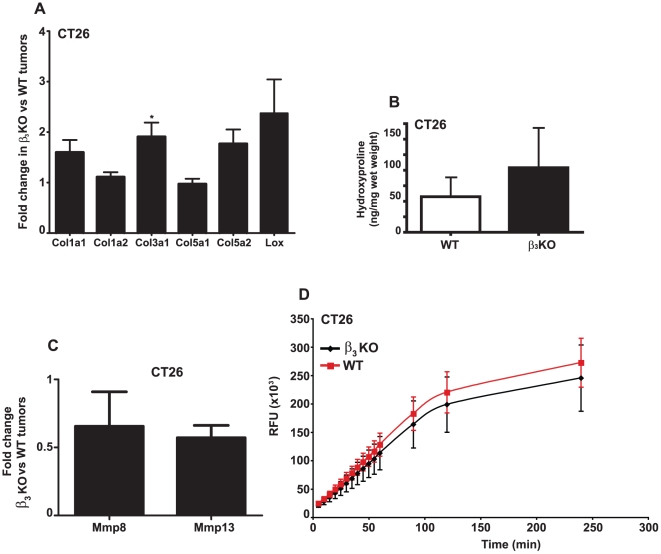
Quantitative RT-PCR analysis, hydroxyproline measurements and assay for MMP-13 activity.
A) Relative mRNA expression of fibrillar pro-collagens and lysyl oxidase (Lox) in CT26 carcinomas from integrin β3-deficient (n = 12) compared to WT mice (n = 11). Bars indicate fold changes in tumors from β3-deficient mice after normalization to tumors from WT mice using the 2−ΔΔCt method. * indicates p<0.05 with Student's t-test. Error bars are SEM. B) Hydroxyproline content in CT26 carcinomas grown in integrin β3-deficient and WT mice (n = 4 per genotype). Data was analyzed with Student's t-test. Error bars are SEM. Differences in collagen content were not significant. C) Fold change in relative mRNA expression for the collagenases Mmp8 and Mmp13 in CT26 carcinomas from integrin β3-deficient (n = 12) compared to WT mice (n = 11). D) CT26 tumor homogenates of each genotype were subjected to a MMP assay (n = 6). Recombinant MMP-13 and samples were activated by 4-aminophenylmercuric acetate for 40 min at 37°C. Fluorescence resulting from the cleavage of the substrate 5-FAM/QXL™520 FRET peptide was measured. Data was analyzed with Student's t-test. Error bars are SD.